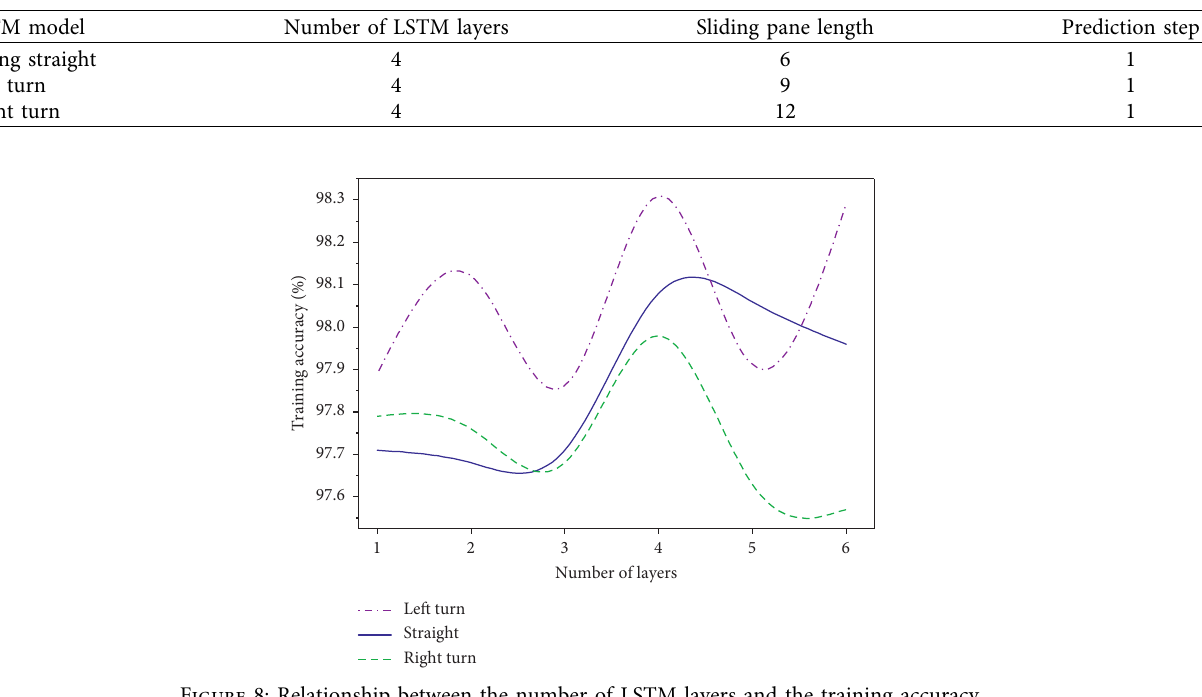
Table 2: LSTM model parameters for each turn.